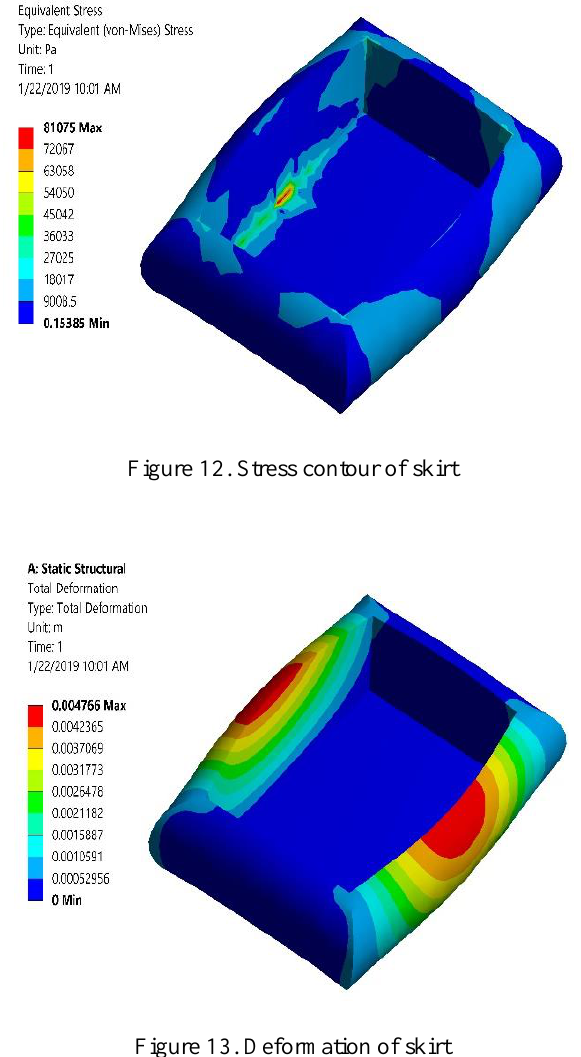
Figure 13. Deformation of